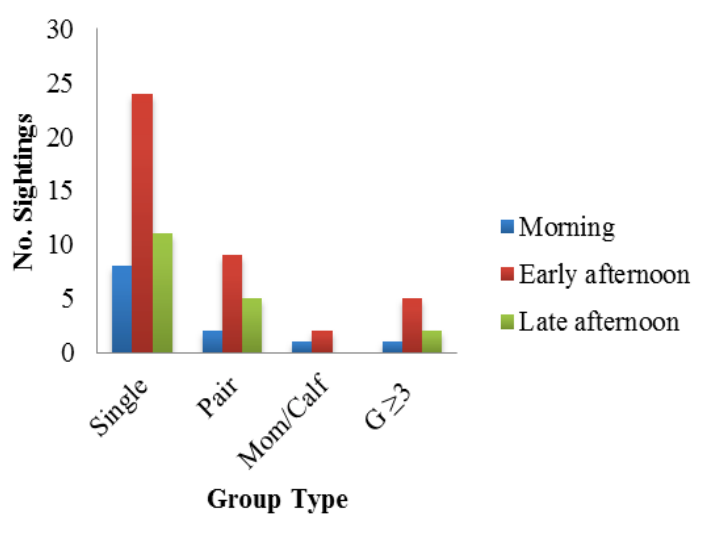
Figure 4. Group type frequency by